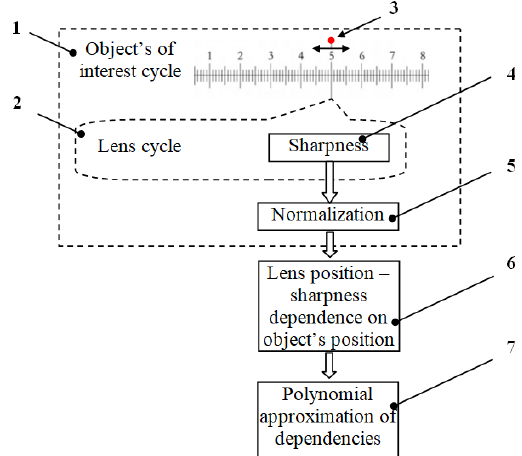
Figure 2. Block diagram of the calibration phase.